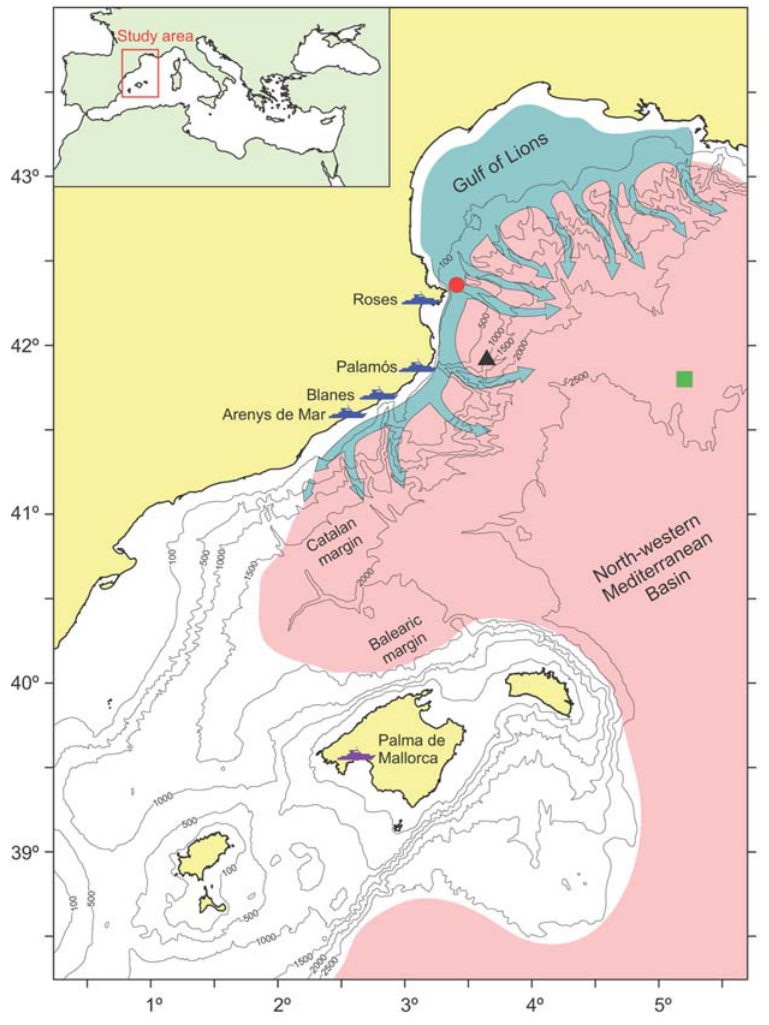
Figure 1. Map of the study area. Bathymetric map of the northwestern Mediterranean showing the location of the fishing harbors considered in this study (blue ships). Landings from Palma de Mallorca fishing harbor (purple ship) are included as supporting information (Figure S5). Moorings in the Cap de Creus Canyon (red circle) and in the basin (green square), and the Wavescan buoy deployed at 1200 m water depth off Palamo´s (black triangle) are also shown. Pale blue arrows indicate the pathway of the dense shelf water cascading mechanism extending from the Gulf of Lions along and across the continental slope, and the faded pink area represents the region affected by the thermo-haline and turbidity anomaly observed in the Western Mediterranean Deep Water after the 1999 and 2005 major cascading events. Both phenomena are inferred from published data [27–33].